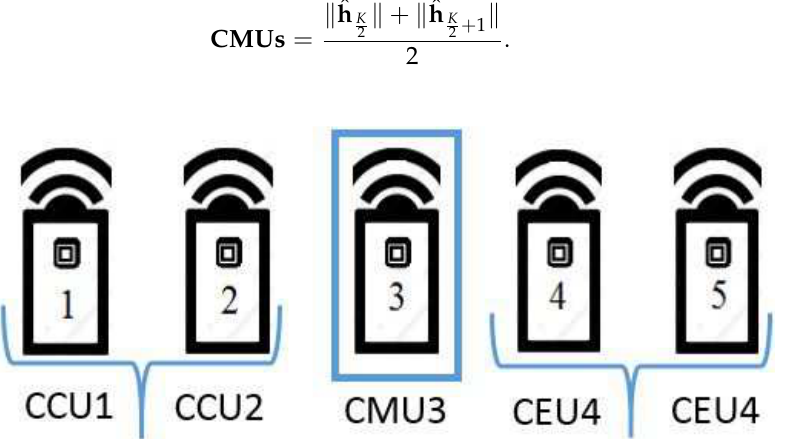
Figure 5. Identifying user location based on distance from base stations